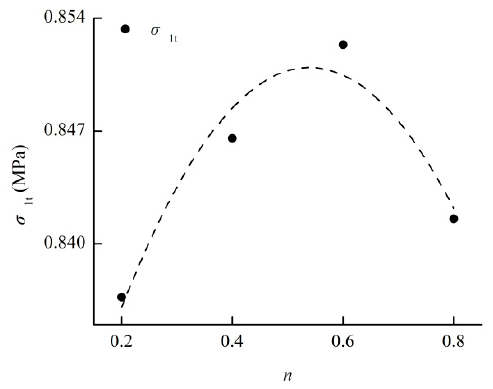
Figure 7. Relationship between the tensile strength and the Talbot index. Table 5. Relationships between the mechanical parameters and the Talbot index. Mechanical Parameter Relationship Correlation